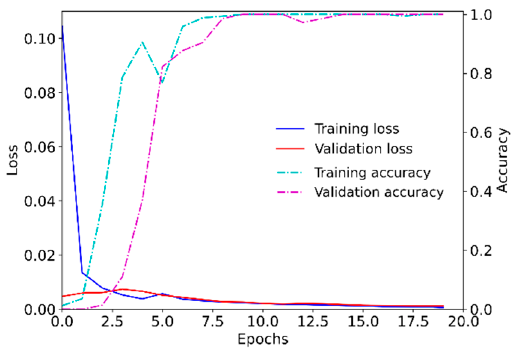
Figure 9. Training and validation accuracies and losses of 1D-UNet in 20 epochs.